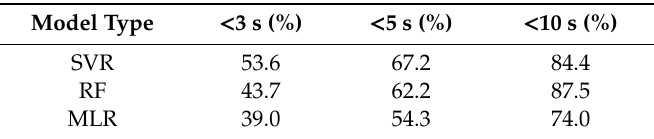
Table 2. The proportion of estimated data depends on the absolute difference between actual dwell time and estimated dwell time by the model types.